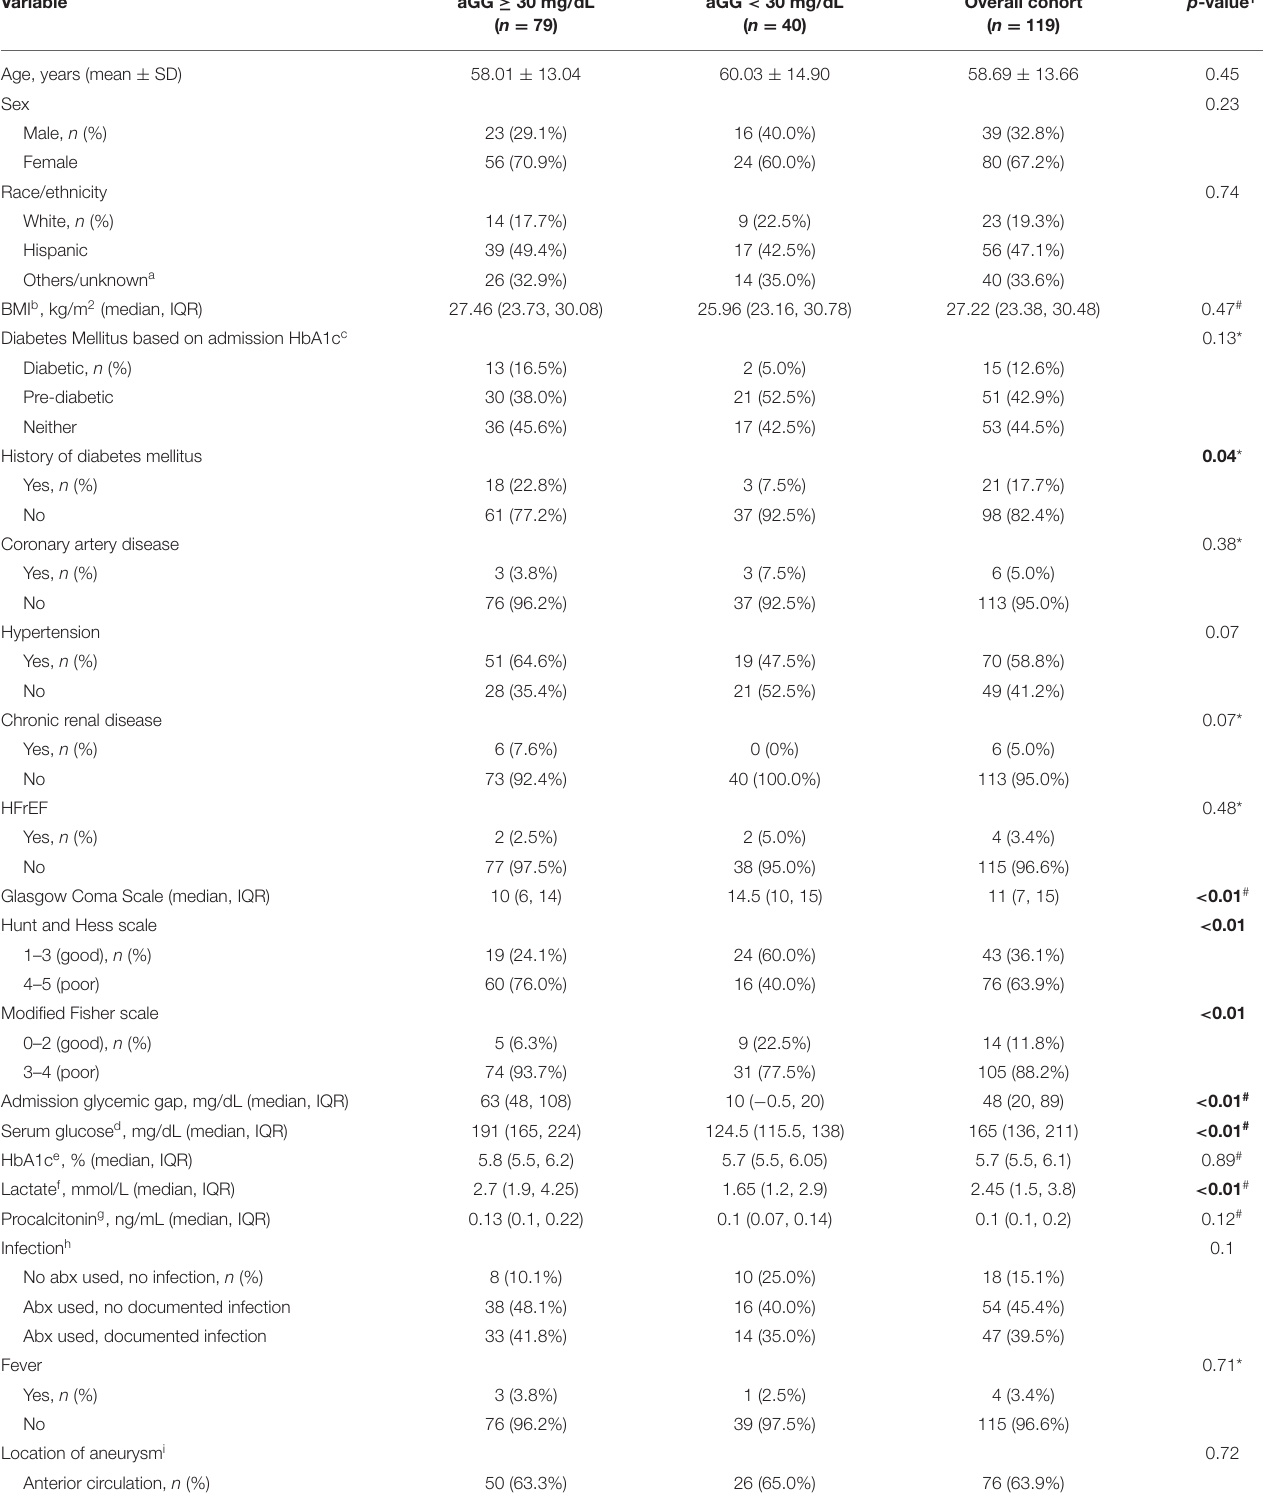
TABLE 1 | Demographic and clinical admission factors between patients with high vs. low admission glycemic gap.